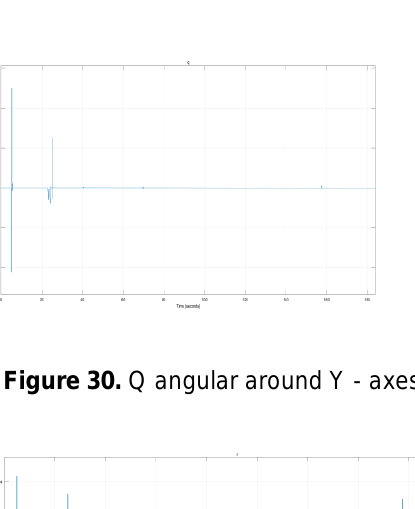
Figure 29. P angular velocity around X - axes for the QAV